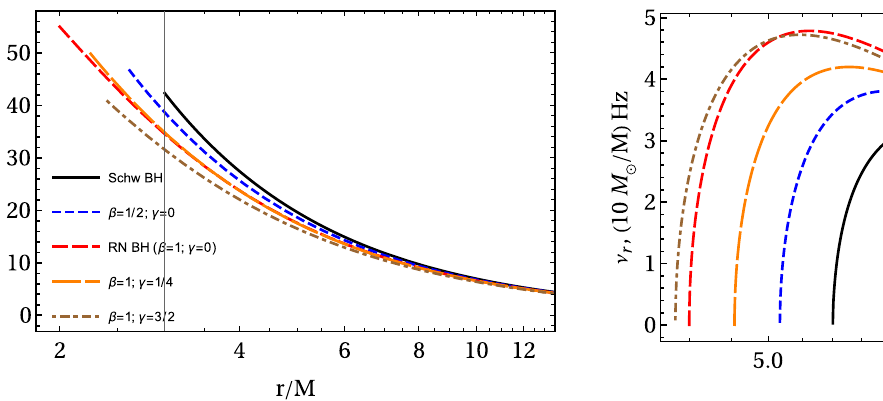
Fig. 11 Radial profile of frequency of radial oscillations of test parti- cles around the BH in EB gravity. In all cases Q = M except